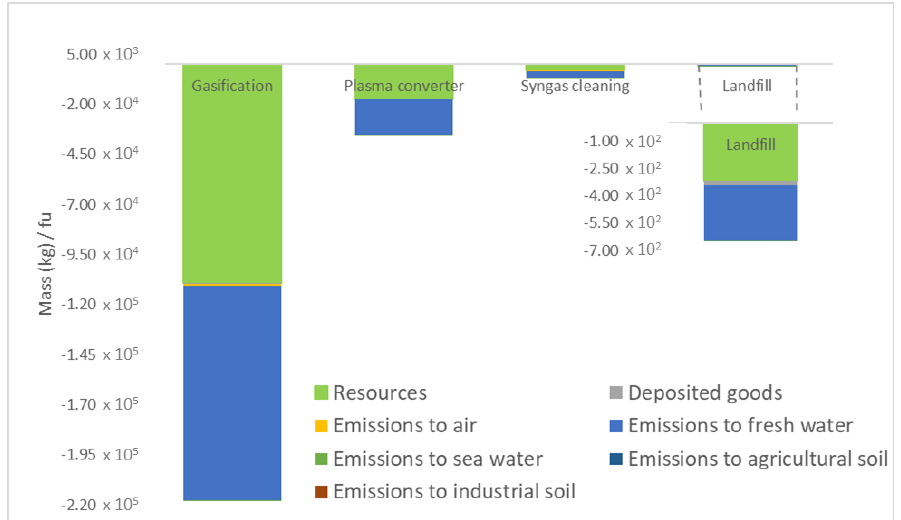
Figure 5. Contribution of the main processes to the global performance of two-stage plasma gasification as waste treatment technique (quantities per ton of treated MSW).